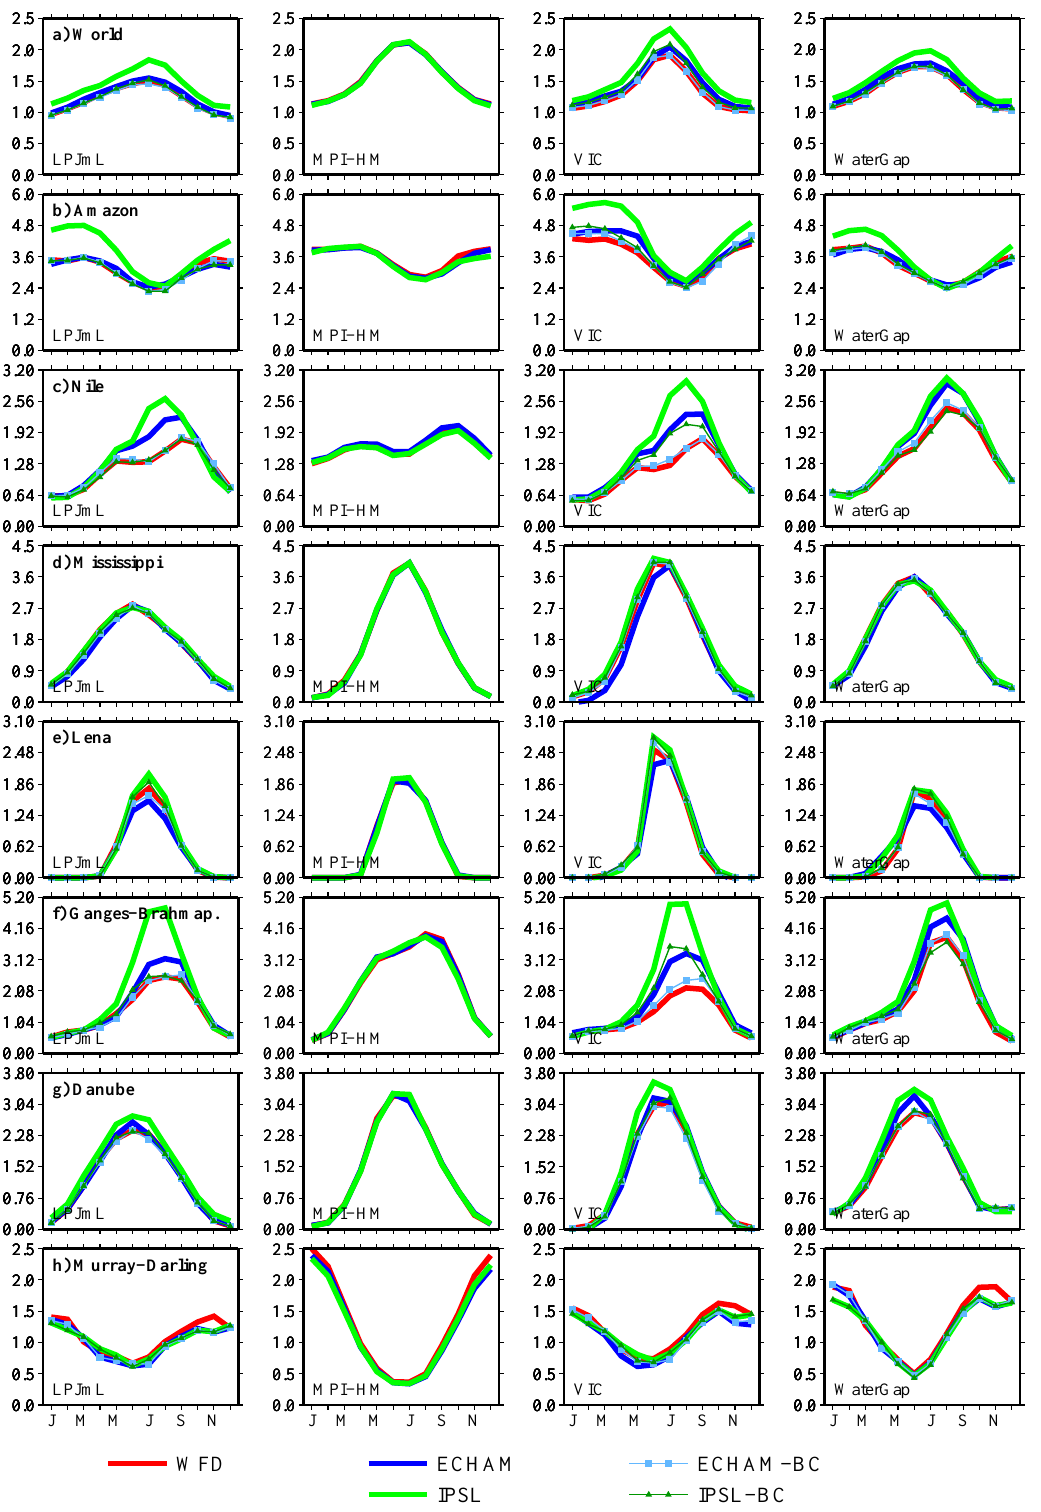
Figure 5: Global terrestrial mean monthly simulated evapotranspiration (mm day -1 ), and 2 Fig. 5. Global terrestrial mean monthly simulated evapotranspiration (mmday − 1 ) , and results for the study basins (control period; 1971– results for the study basins (control period; 1971-2000). Original and bias corrected results 3 2000). Original and bias corrected results when when applicable. 4